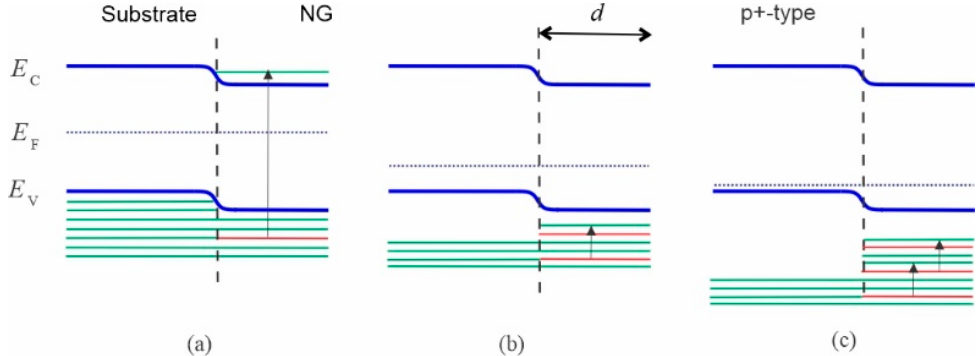
Figure 1. Basic energy-band diagrams of NG layers fabricated on the surface of ( a ) an intrinsic semiconductor, ( b ) a p-type, and ( c ) a p+-type. The green lines refer to energy levels occupied by electrons, and red lines refer to energy levels forbidden by NG patterns.